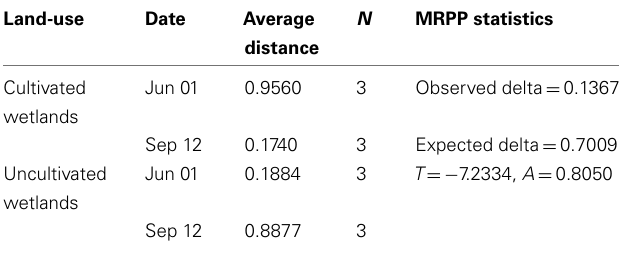
testing of the null hypothesis of no significant difference in denitrifier nosZ community composition between land-use and time